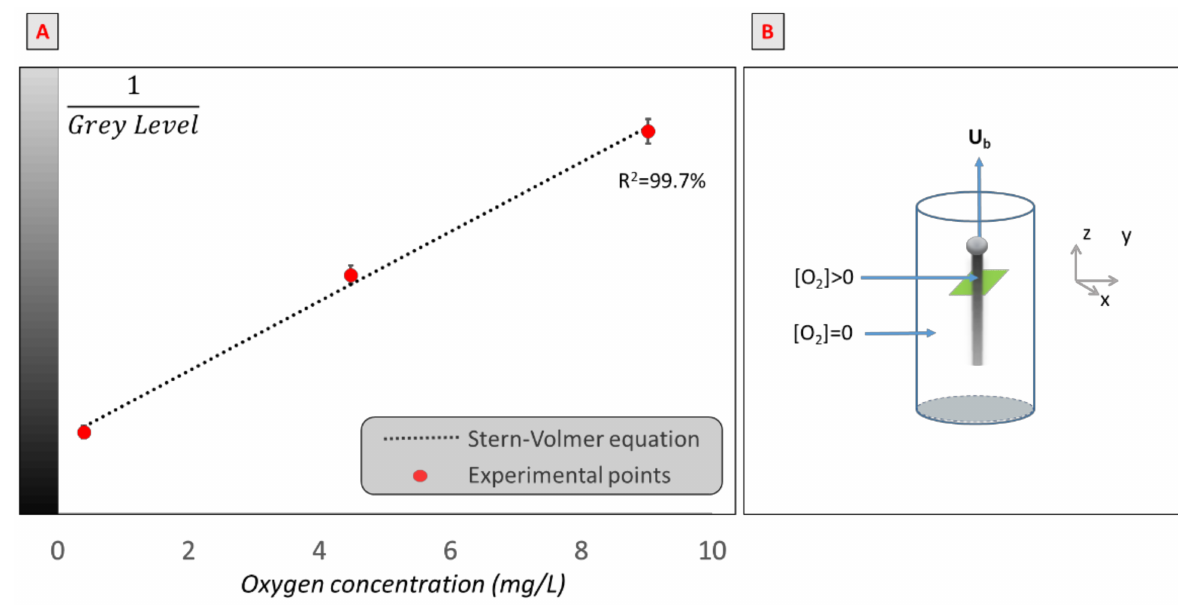
Figure 3. ( A ) Example of calibration curve: inverse of gray level of images obtained versus oxygen concentration in a solution of water and ruthenium (III). ( B ) Schematic representation of the bubble rising in its